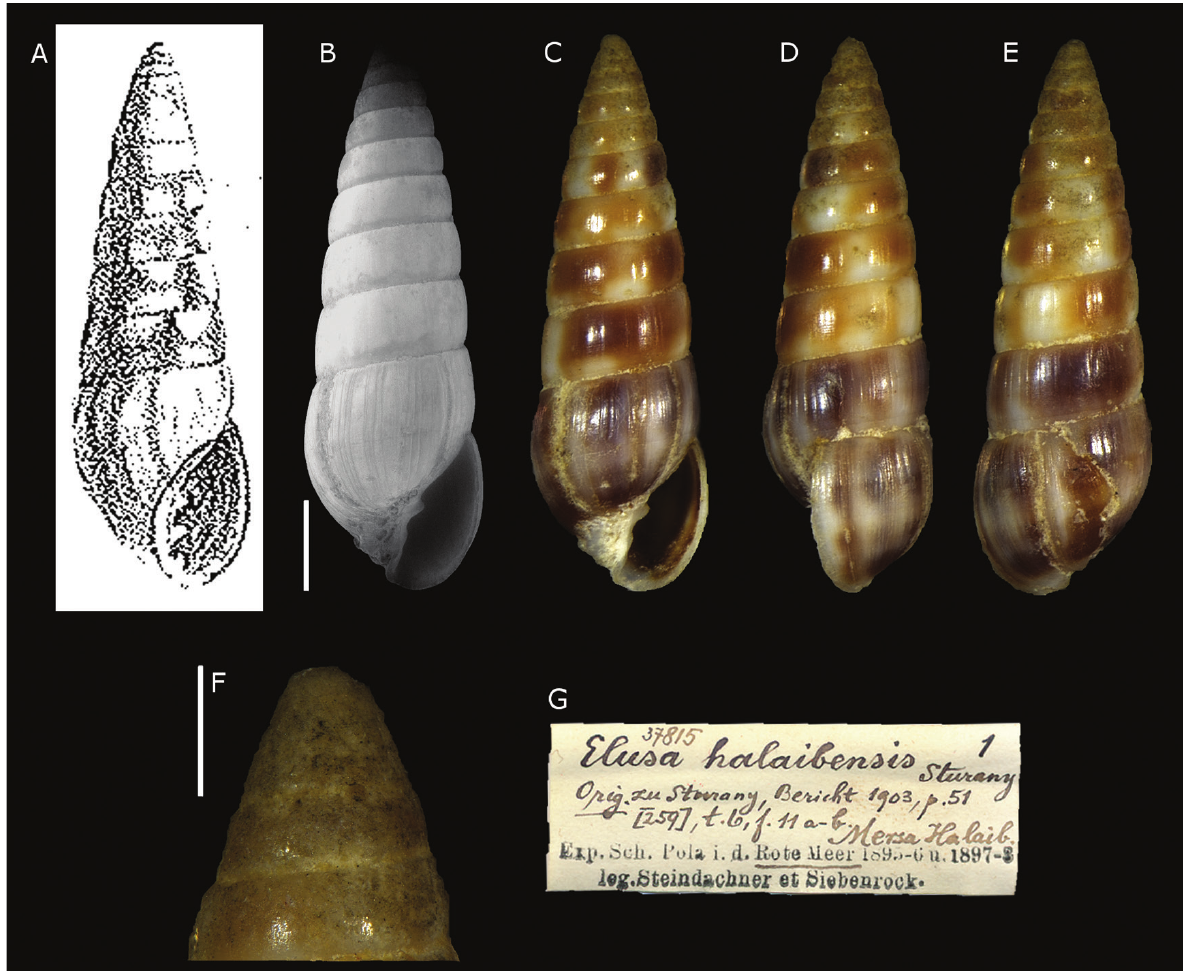
Figure 31. Elusa halaibensis Sturany, 1903, Locality 30 (Halayeb, Egypt, Red Sea). A . Original figure by Sturany (1903). B–F . Holo- type, NHMW 37815: front ( B–C ), right side ( D ), back ( E ), protoconch ( F ). G . Original holotype label. Scale bars: B–E : 2 mm, F : 1 mm.